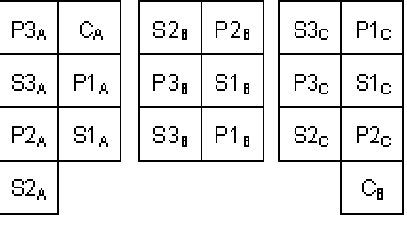
FIGURE 2 . Layout of the plots. C: control; pig manure doses P1-P2-P3; sewage sludge doses S1- S2-S3. A, B, and C: replicates of each